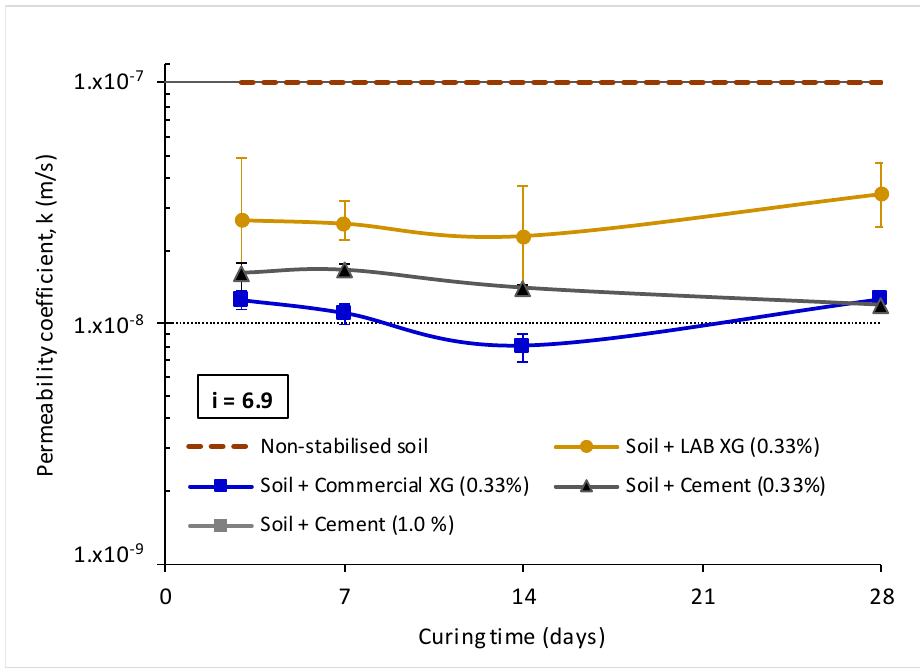
Figure 5. Effect of curing time on the permeability coefficient for a hydraulic gradient of 6.9.